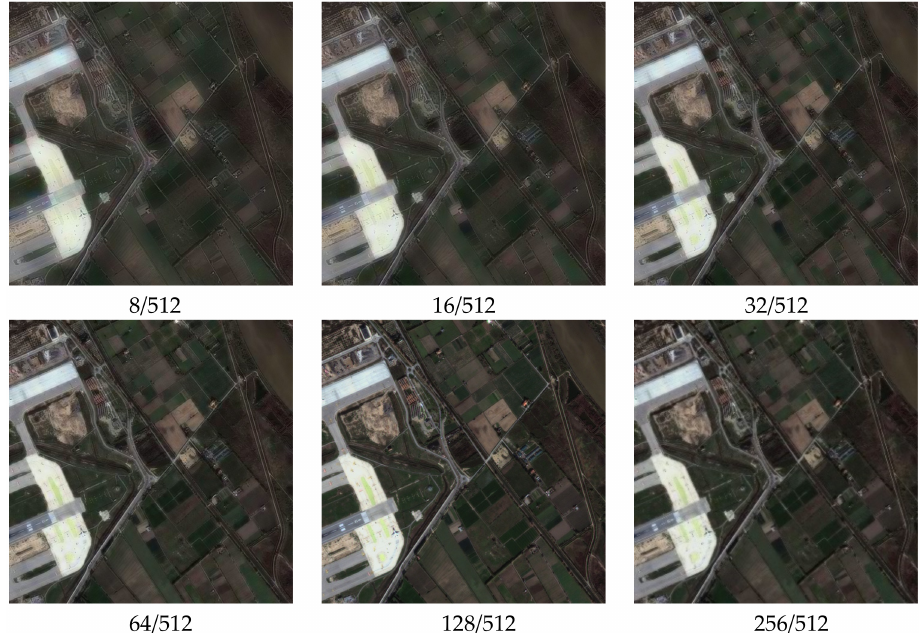
Figure 7. Fusion results at different